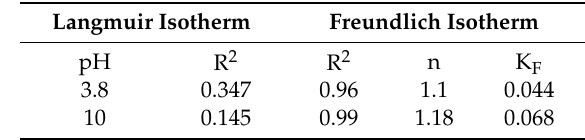
Table 2. Sorption isotherms of iron(II) on the surface of the composite at pH = 3.8 and 10.